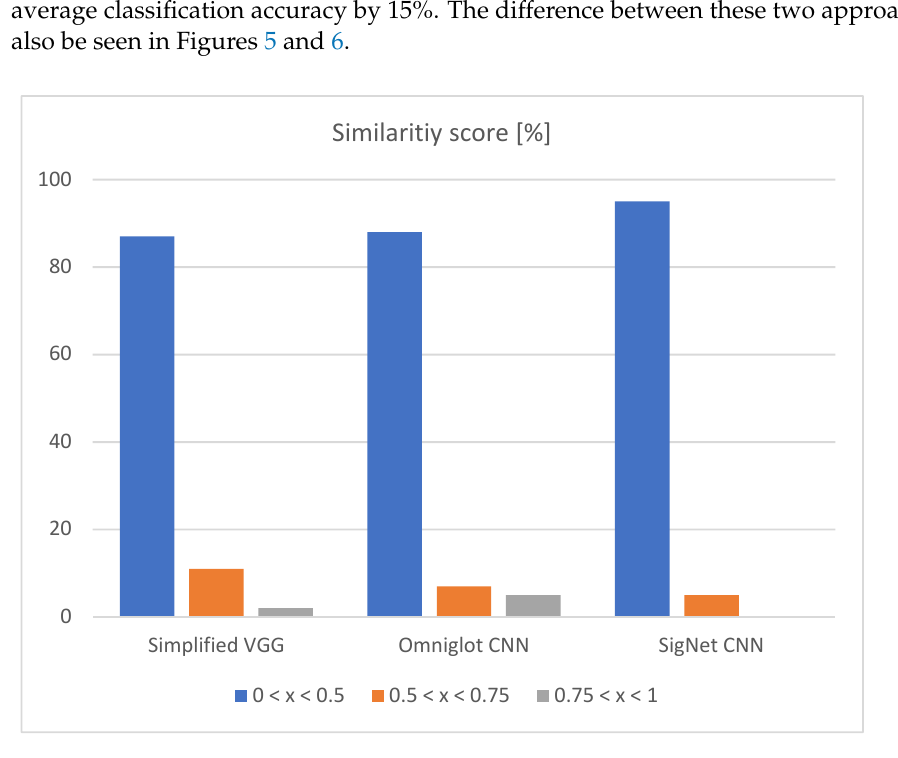
Figure 6. Input vs. highest similarity image from each class—similarity score.